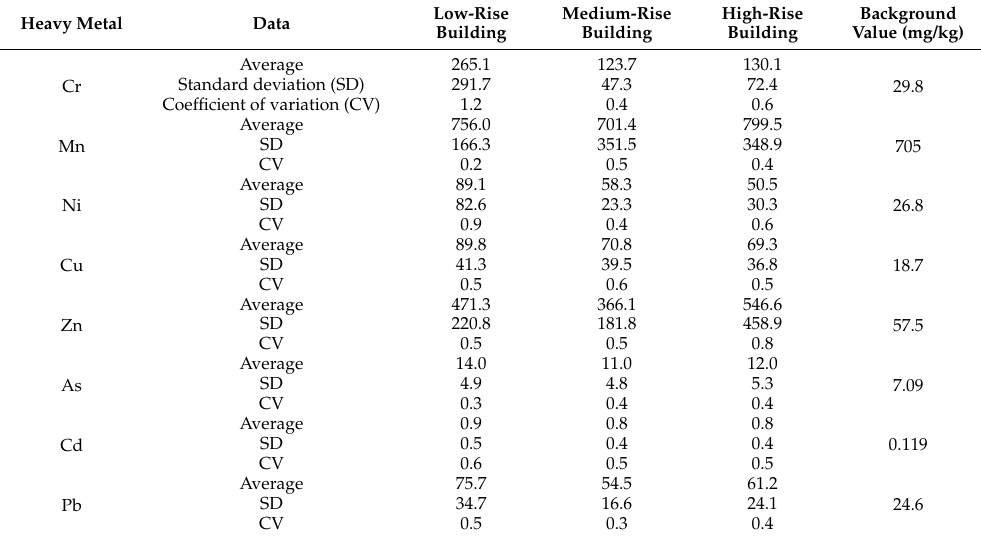
Table 4. Statistics of heavy metal elements in dust fall on various